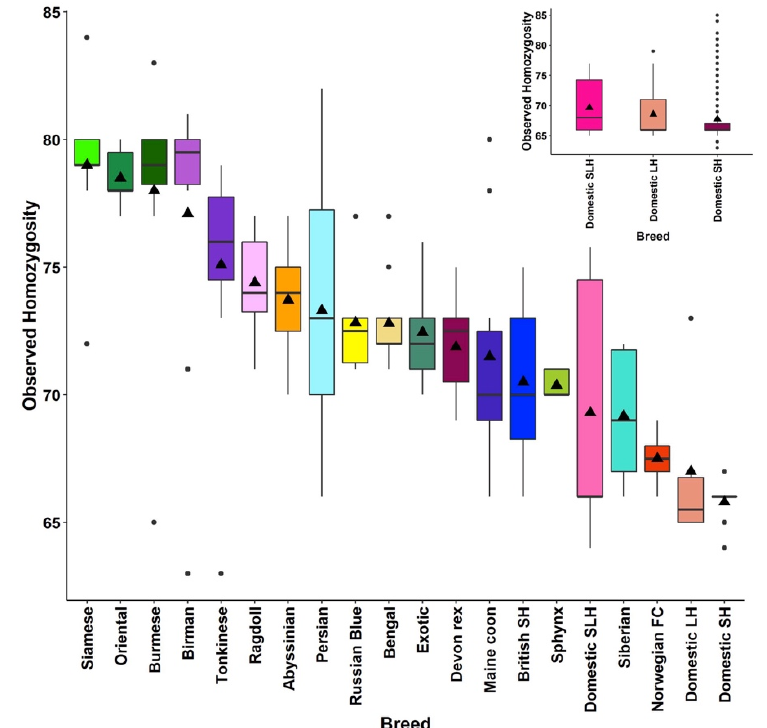
Figure 7. A boxplot diagram, representing the observed homozygosity for the balanced dataset, the range for the random-bred cats (i.e., DSH, DLH, and DSLH) is 64–76%. When all random-bred cats in the full dataset are examined, the range of observed homozygosity is 63–85% (inset). The black triangle symbol represents the mean observed homozygosity.